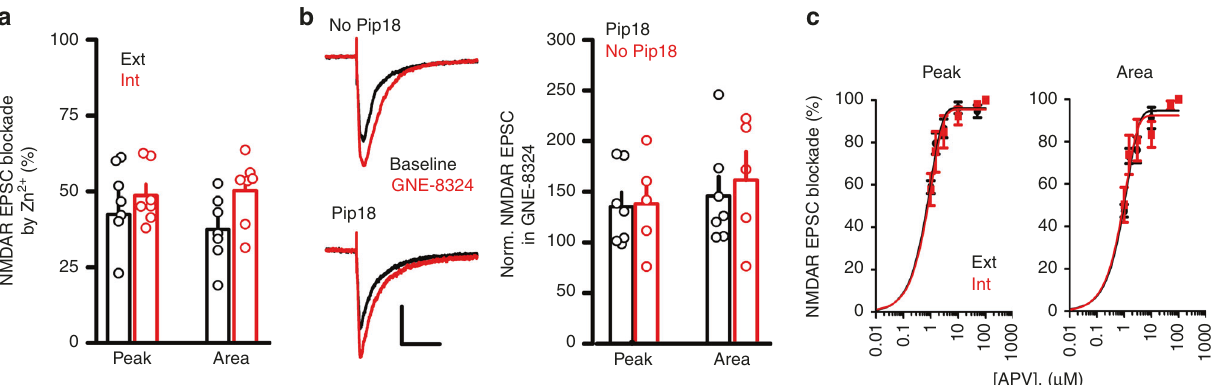
Fig. 2 Synaptic GluN2A subunit composition do not underlie inhibitory neuron-selective GNE-8324 potentiation. a Similar blockade of NMDAR EPSC by ZnCl 2 in excitatory (Ext, N = 7) and inhibitory (Int, N = 7) neurons suggests similar contribution of diheteromeric GluN1/2A NMDARs to NMDAR EPSCs. b Similar GNE-8324 potentiation of NMDAR EPSCs in inhibitory neurons in the presence or absence of the GluN2B-selective inhibitor Pip18. Scale